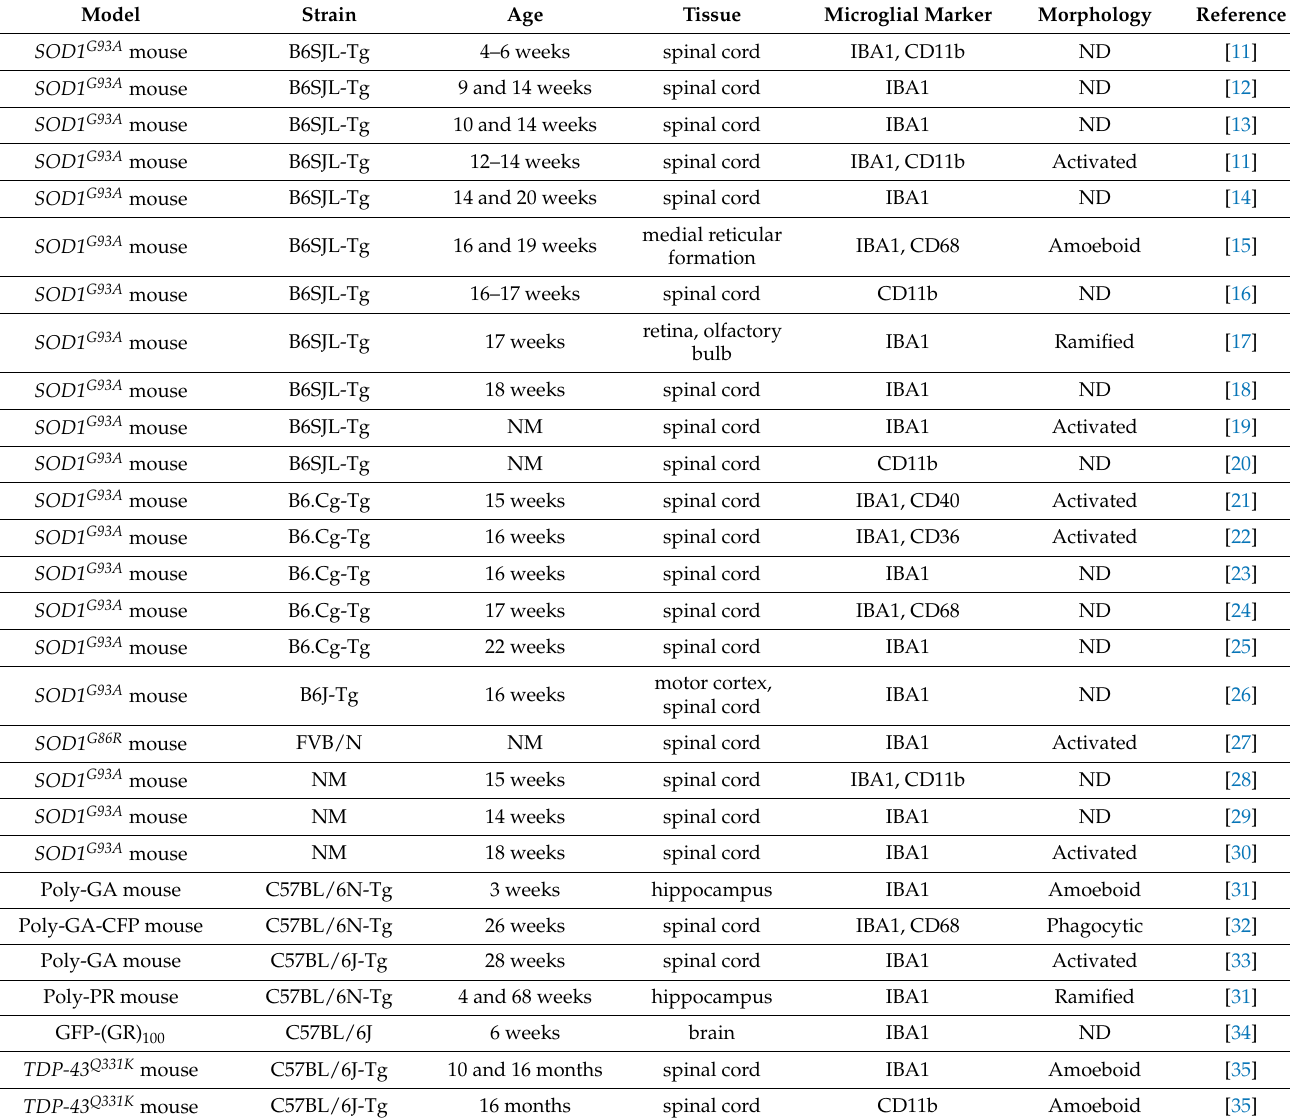
Table 1. Morphology of microglia in the different amyotrophic lateral sclerosis (ALS) animal models based on genetic background, age, strain, collected tissue and microglial